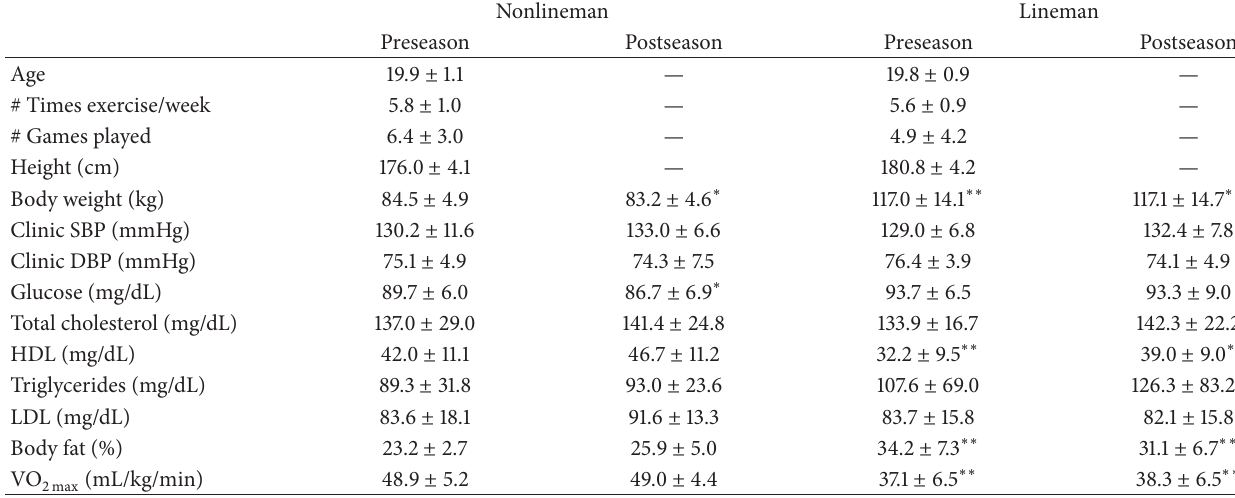
Table 2: Football player responses over a season.